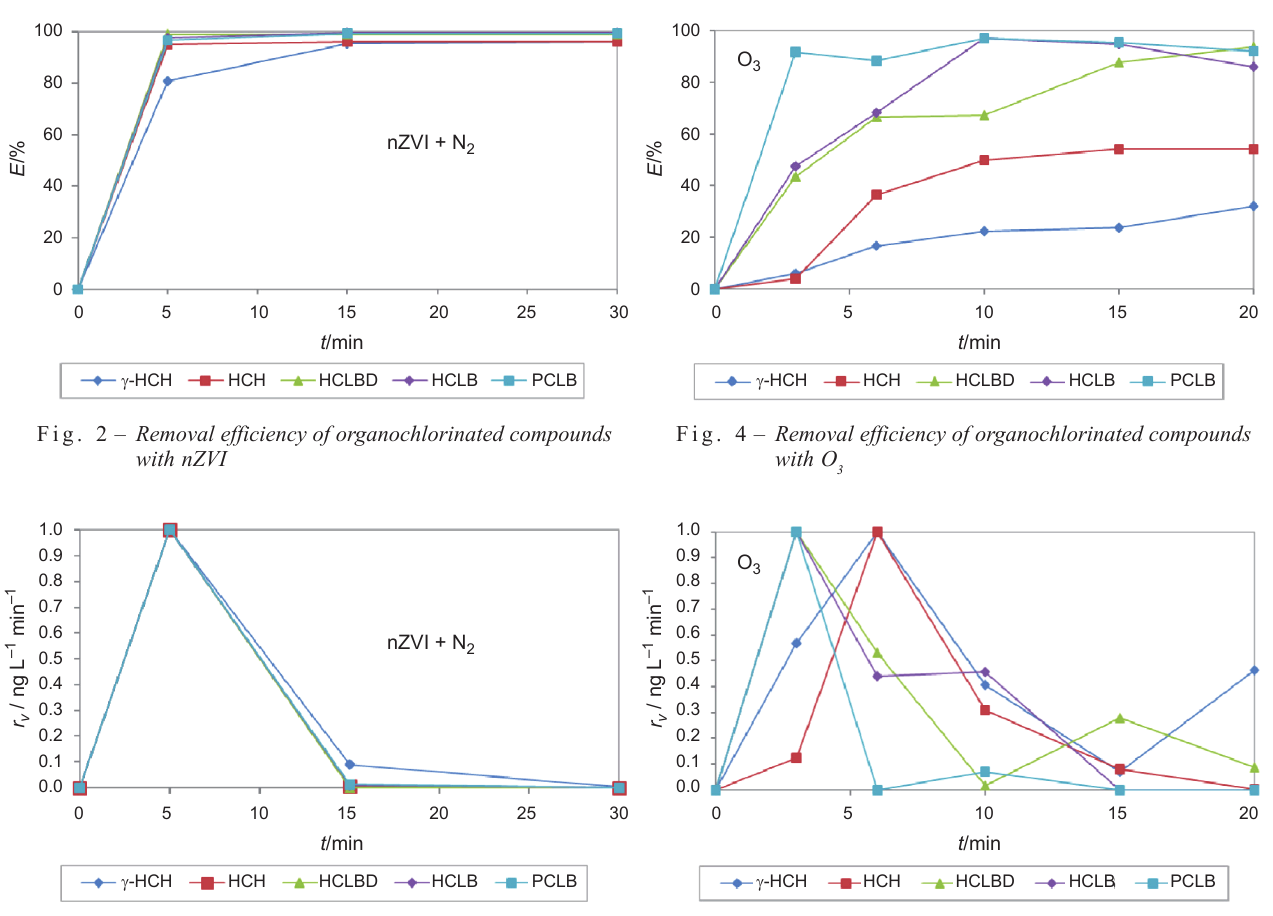
Fig. 3 – Removal rates of organochlorine compounds with nZVI